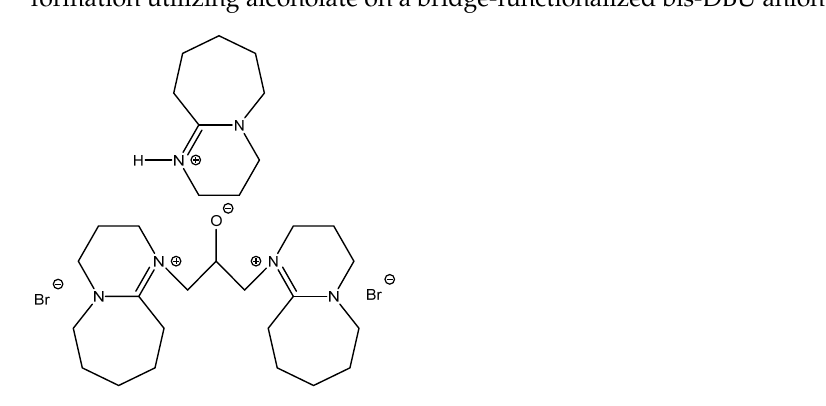
Scheme 11. Carbonation of EPIC using simulated flue gas (15% CO 2 in nitrogen) catalyzed by OH- functionalized DBU-based IL at ambient pressure and at 30 °C [95].